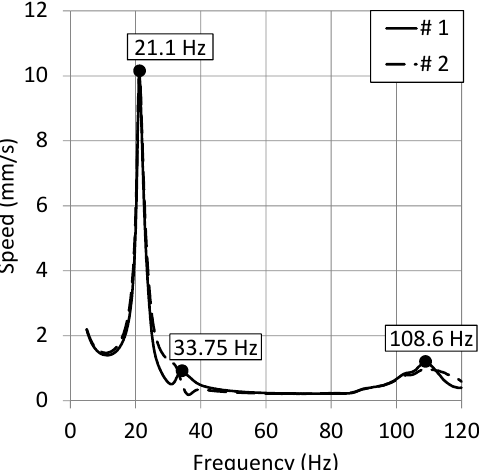
Figure 5: Diagram of the speed registered experimentally on the tip of lamina #1 (solid line) and lamina #2 (dashed line).